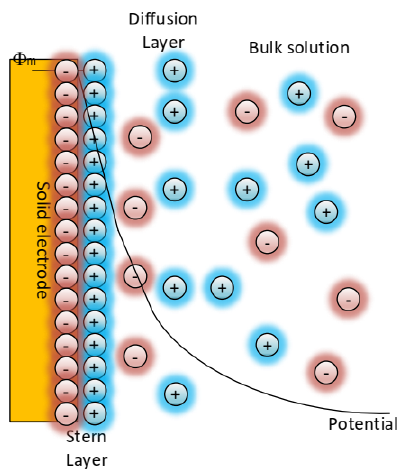
Figure 1. Schematic of the electric double